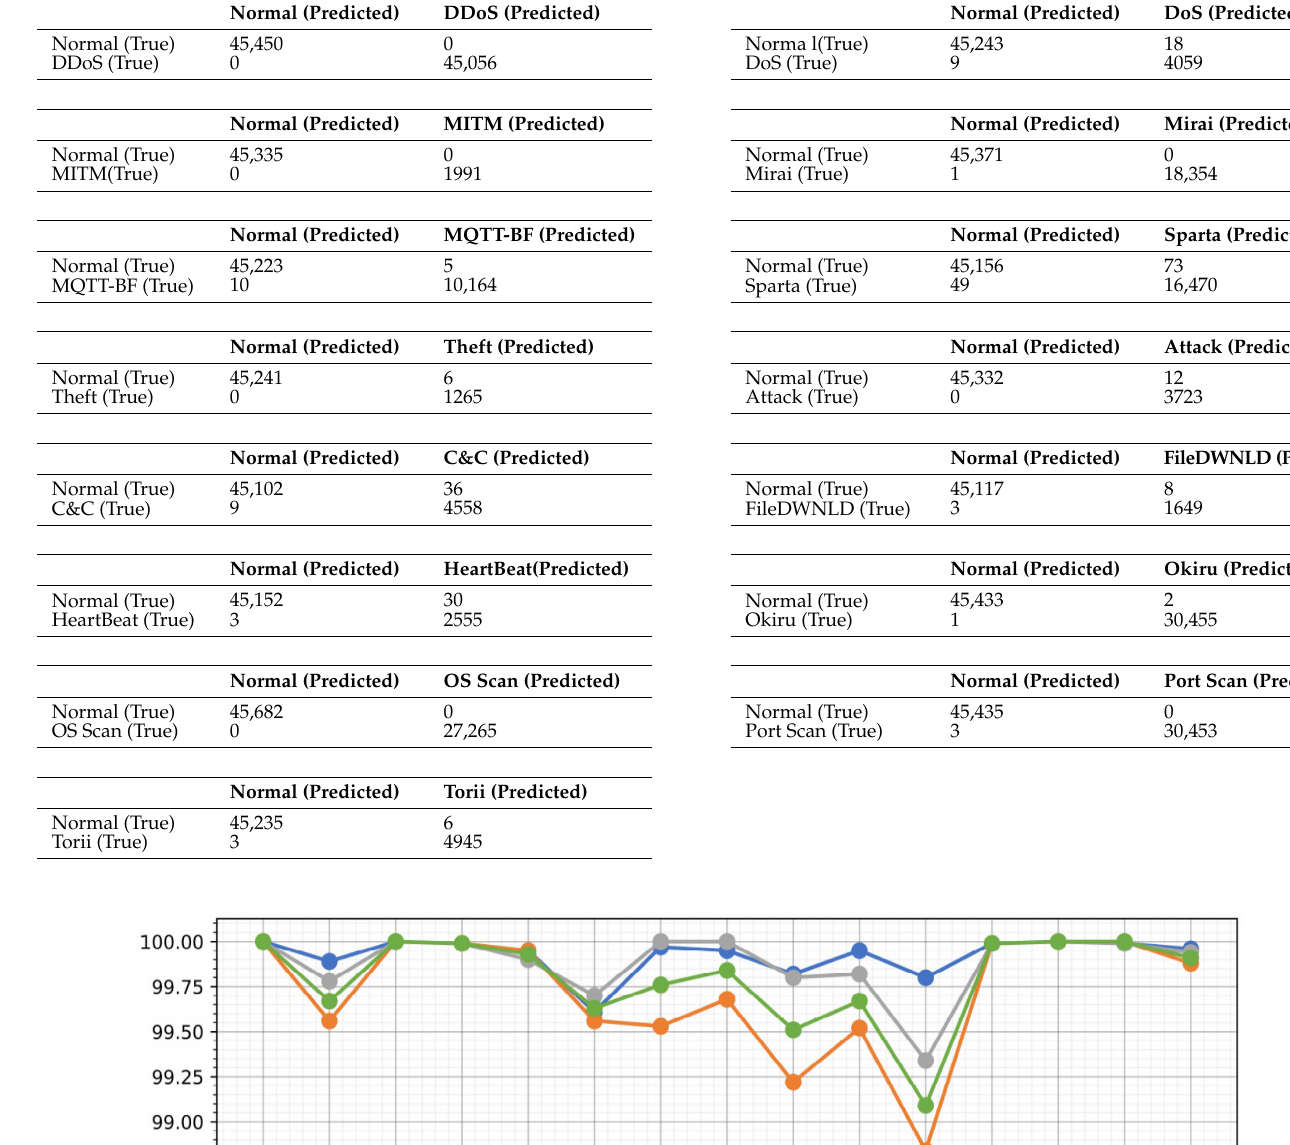
Table 12. Confusion matrices binary CNNGRU model.